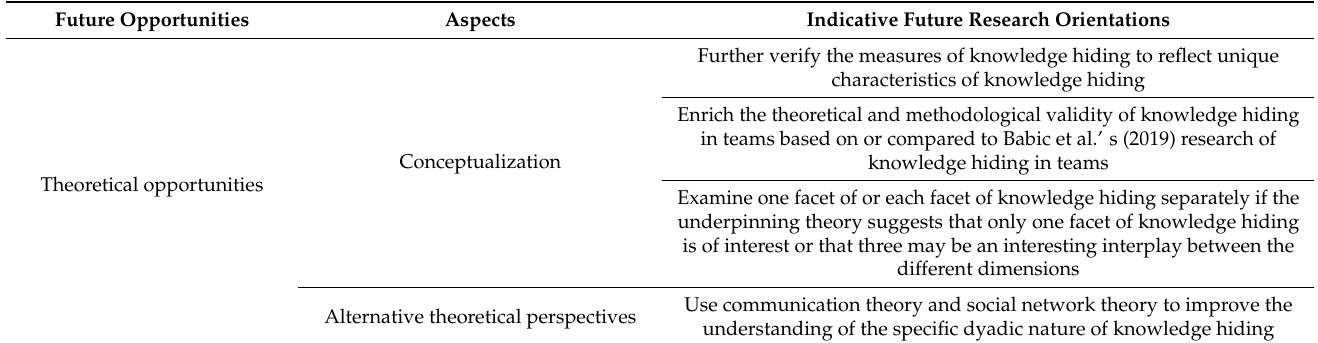
Table 7. A summary of directions for future research on knowledge